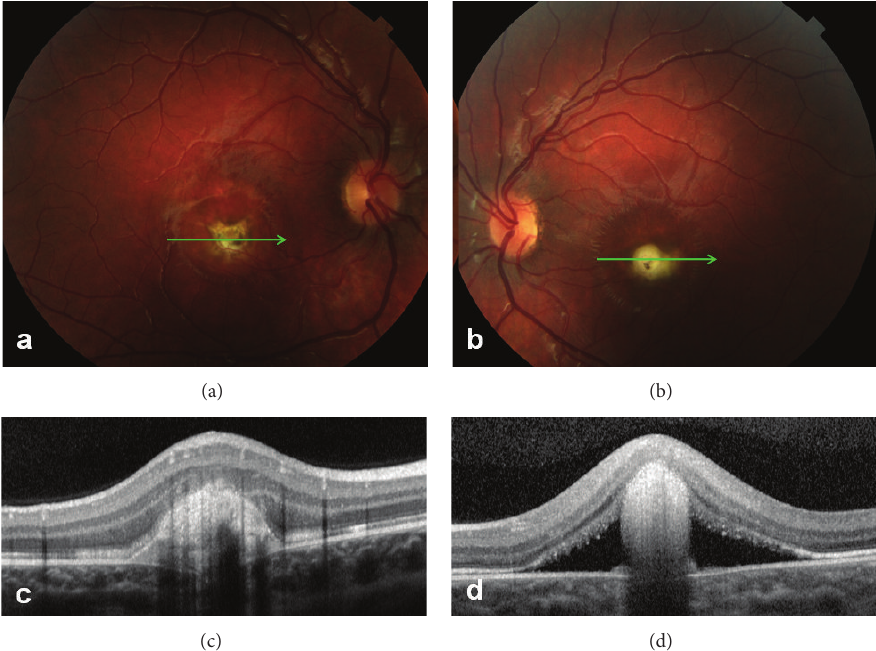
Figure 3: Fifteen days after high-dose steroid therapy. (a, b) Ophthalmoscopy demonstrates round yellow juxtafoveal material circled by pigment in the right eye (a) and yellowish foveal material surrounded by fluid in the left eye (b). (c, d) SD-OCT confirms hyper-reflective material in the vitelliform space and no fluid in the right eye (c), and smaller round hyper-reflective mass in the vitelliform space with adjacent subretinal fluid in the left eye